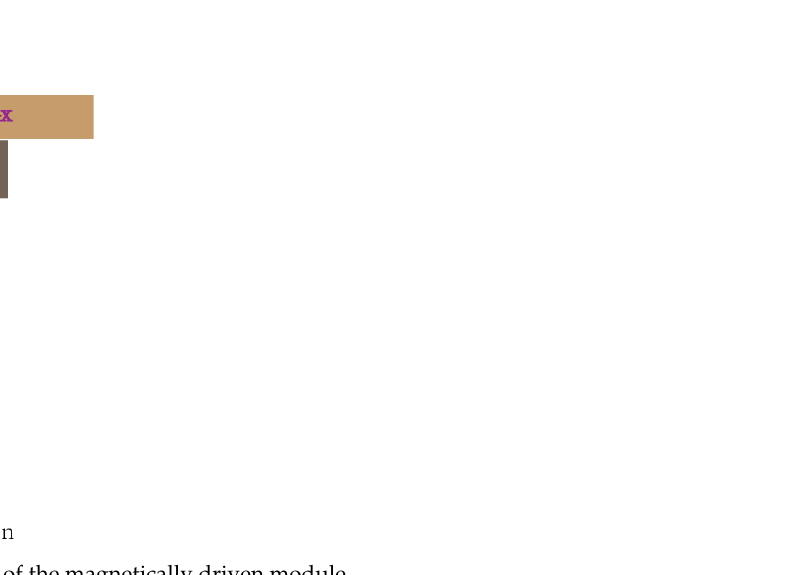
Figure 11. Scheme of the magnetically driven module.